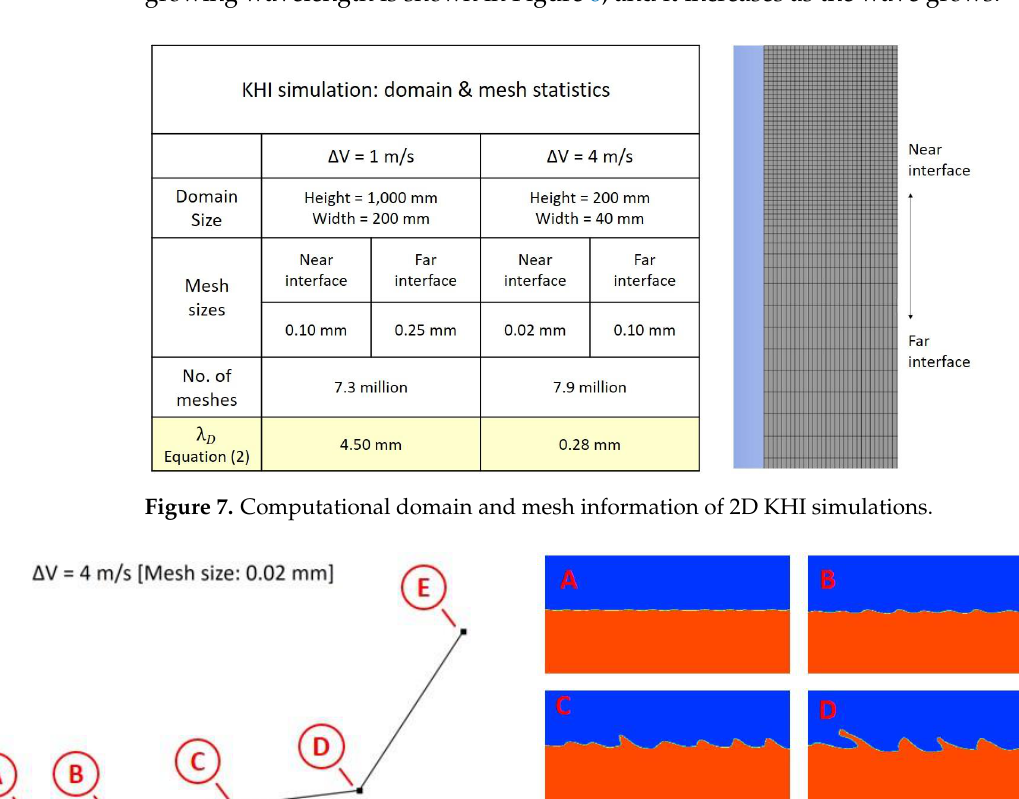
Figure 9. Wavelength analysis by Fast Fourier Transform (FFT) technique on melt volume fraction: melt volume fraction near interface ( left ), FFT spectrum ( right ). As seen in Figure 9, the FFT result does not show a unique frequency, but at least the dominant frequency of the peak magnitude can be identified. The wavelength obtained by the FFT technique was compared with the graphical measurement using the contour plot of melt volume fraction and the agreement was acceptable. The value of λ D at the earliest time when it can be identified was 0.45 mm for relative velocity of 4.0 m/s and 5.64 mm for 1.0 m/s. The linear analysis of KHI (Equation (2)) gives 0.28 mm for relative veloc- ity of 4.0 m/s and 4.8 mm for 1.0 m/s. Comparison of these numbers implies that λ D at the beginning of wave growth obtained by CFD simulation is close to the estimate by Equation (2). However, as the wave grows further, λ D increases gradually. The particle size information was obtained by the same way as shown in Figure 5. The interface shape and particles at the full growth of waves is illustrated in Figure 10. The size distributions at selected times are shown in Figure 11. At the early time, the par- ticle size is mostly 0.3 mm, but the distribution is widened as wave growth proceeds, but the Sauter-mean diameter was less than 1.0 mm at all times of calculation.